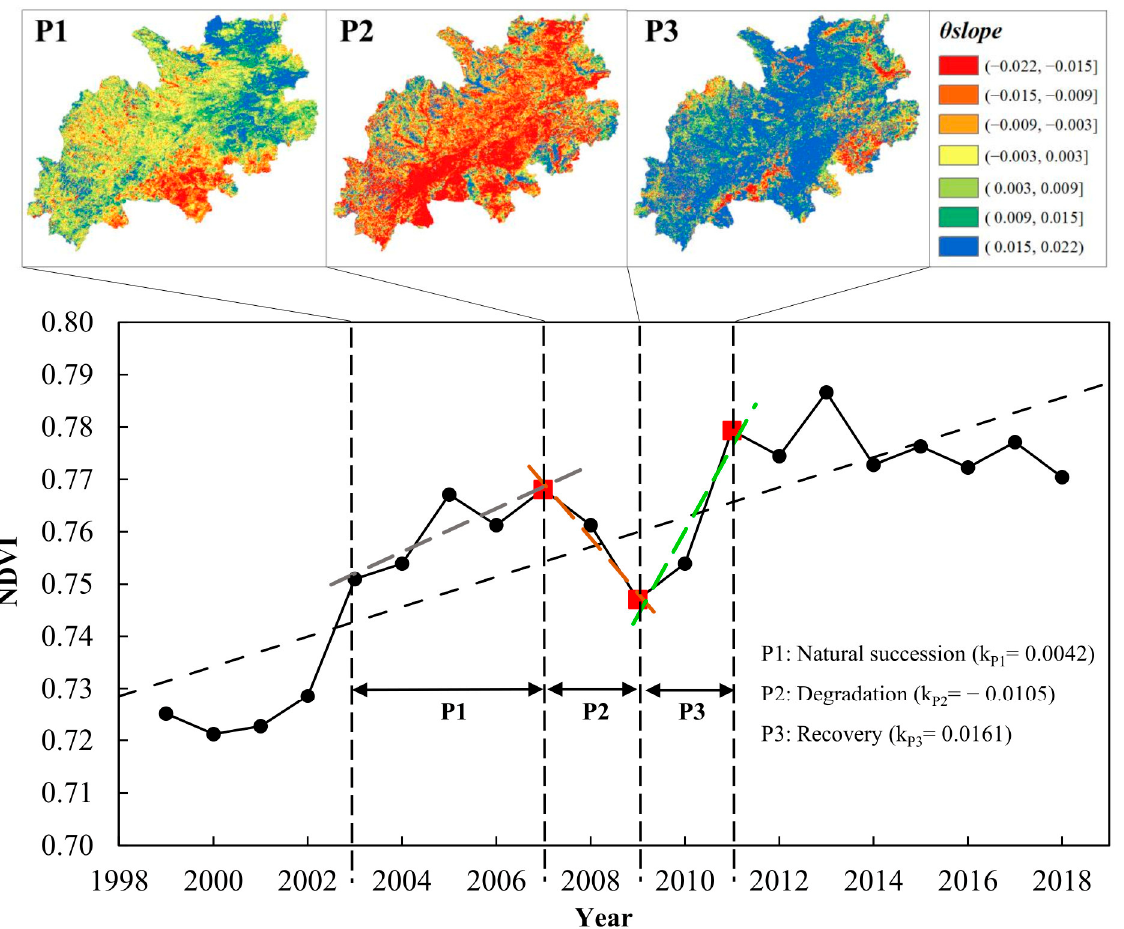
Figure 5. Inter-annual variation of NDVI in the study area. P1, P2, and P3 represent three periods of the pre-earthquake natural succession, post-earthquake degradation, and rapid recovery of NDVI in the study area, respectively. The corresponding k refers to the slope of the NDVI linear fit within the period.